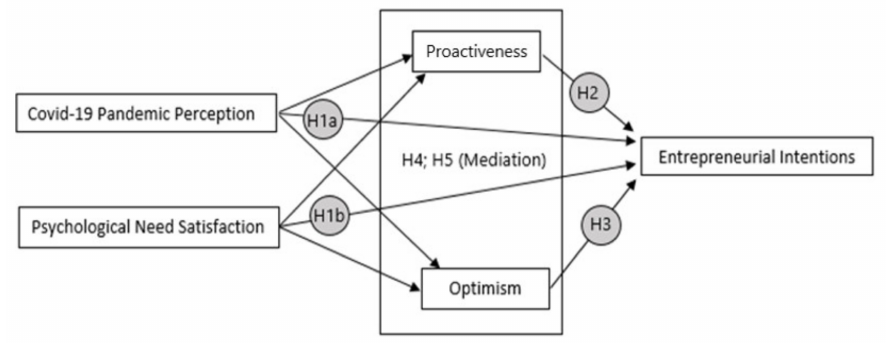
Figure 1. Conceptual